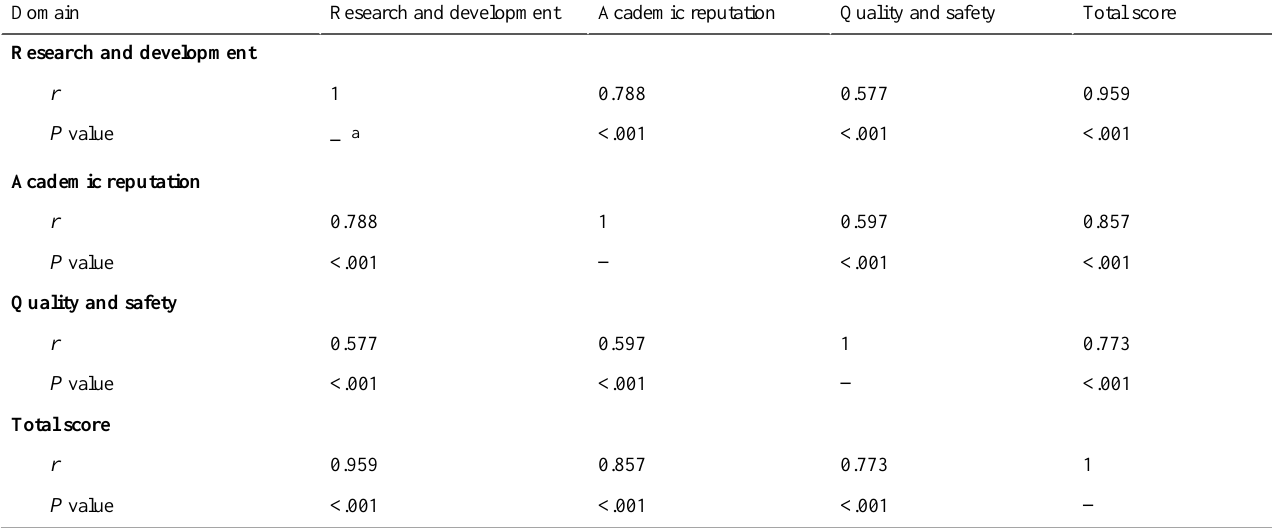
Table 7. Correlation coefficients ( r ) between scores of the three domains for all hospitals evaluated